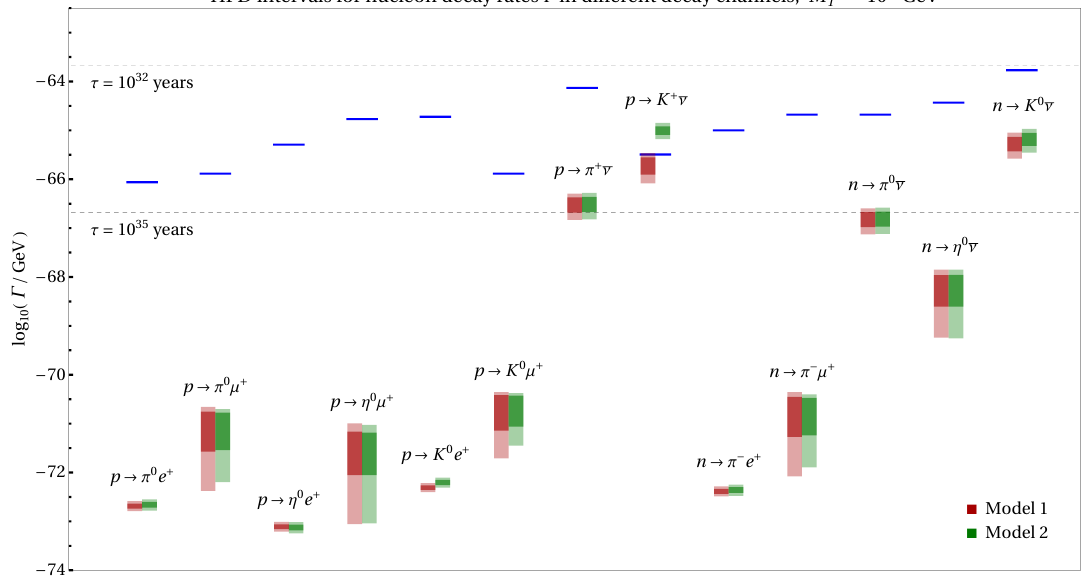
Figure 4 . The 1 - σ (dark) and 2 - σ (light) HPD regions predicted via MCMC for nucleon decay rates in both models using a benchmark cMSSM point and a fixed effective triplet mass M eff The blue line segments indicate current experimental